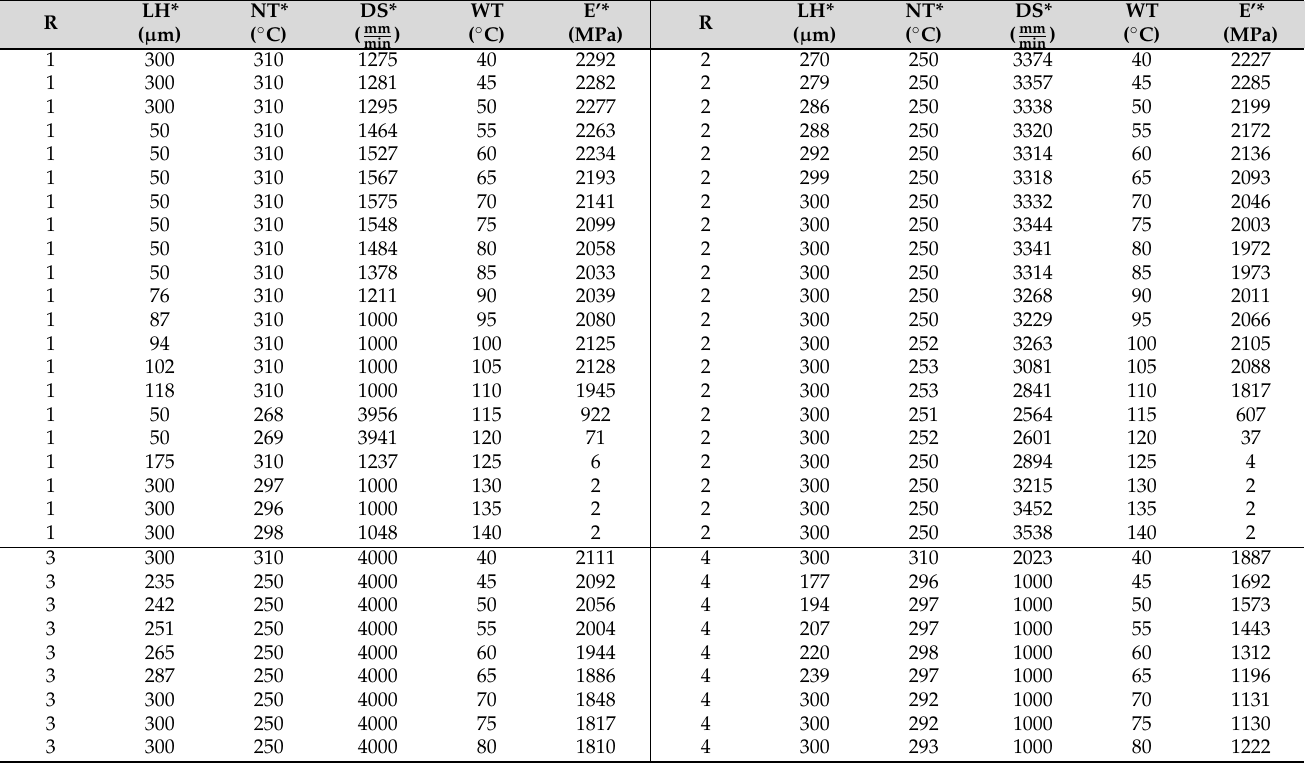
Table A1. The optimum values (look-up table) of the process parameters using PSO on E (cid:48) at each raster orientation level and under each working